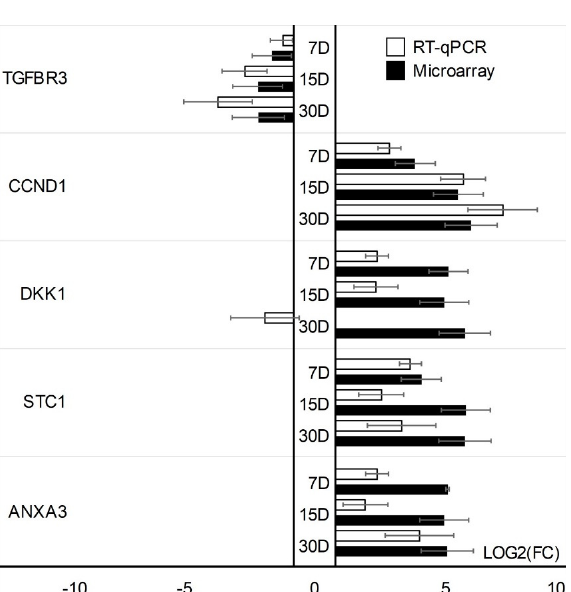
Figure 5. RT − qPCR validation of microarray change expressions (log(FC)) in CCs. Validation of the microarray method was performed in three separate biological repetitions. Each of the biological repetitions was performed in three technical repetitions; D: day of culture; FC: fold change.